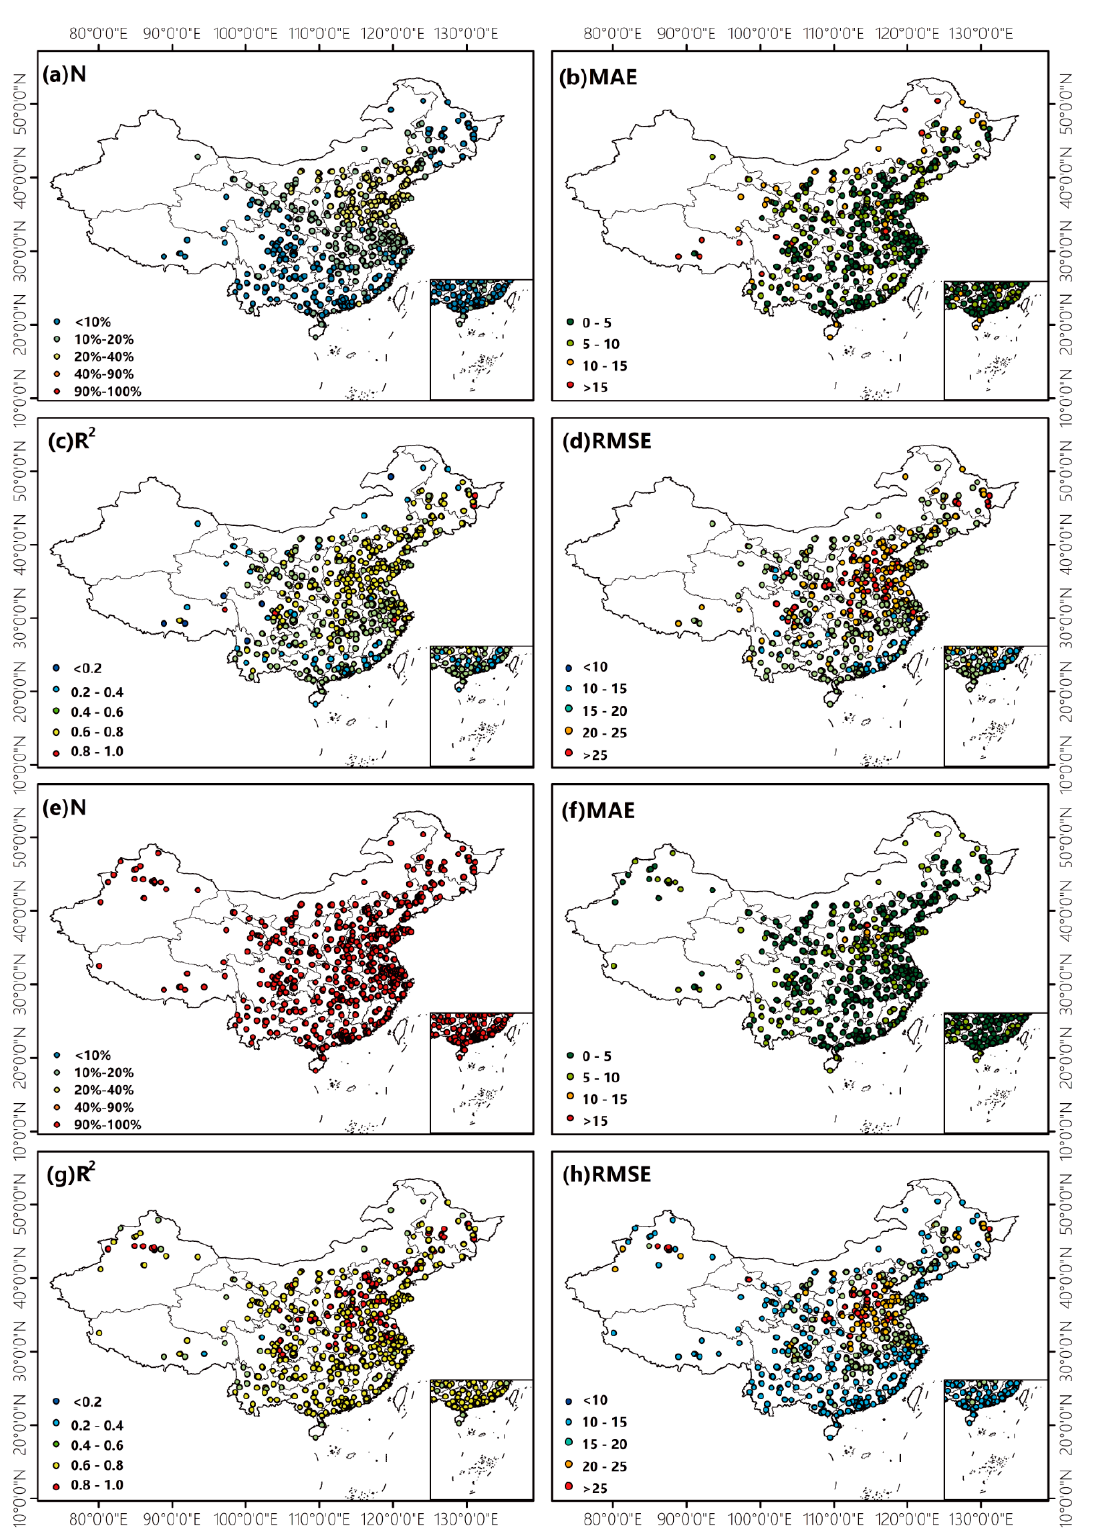
Figure 3. The valid observed frequency, CV RMSE, R 2 and MAE of individual site across China produced by the RF model using AOD H ( a – d ) and AOD H+M ( e – h ), respectively. Although the overall accuracy of the model is reliable, the performance varies greatly in the typically populated regions. The values of CV R 2 and RMSE are highest in the North China Plain, which has a dense network of monitoring sites and high PM 2.5 concentra- tions. Before the AOD was gap filled with MERRA-2, the site-specific cross-validation